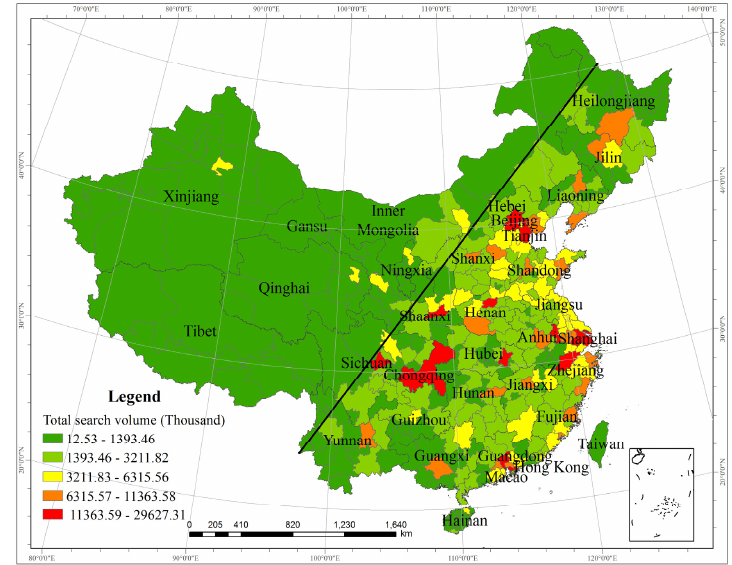
Figure 1. Spatial distribution of the total Baidu search